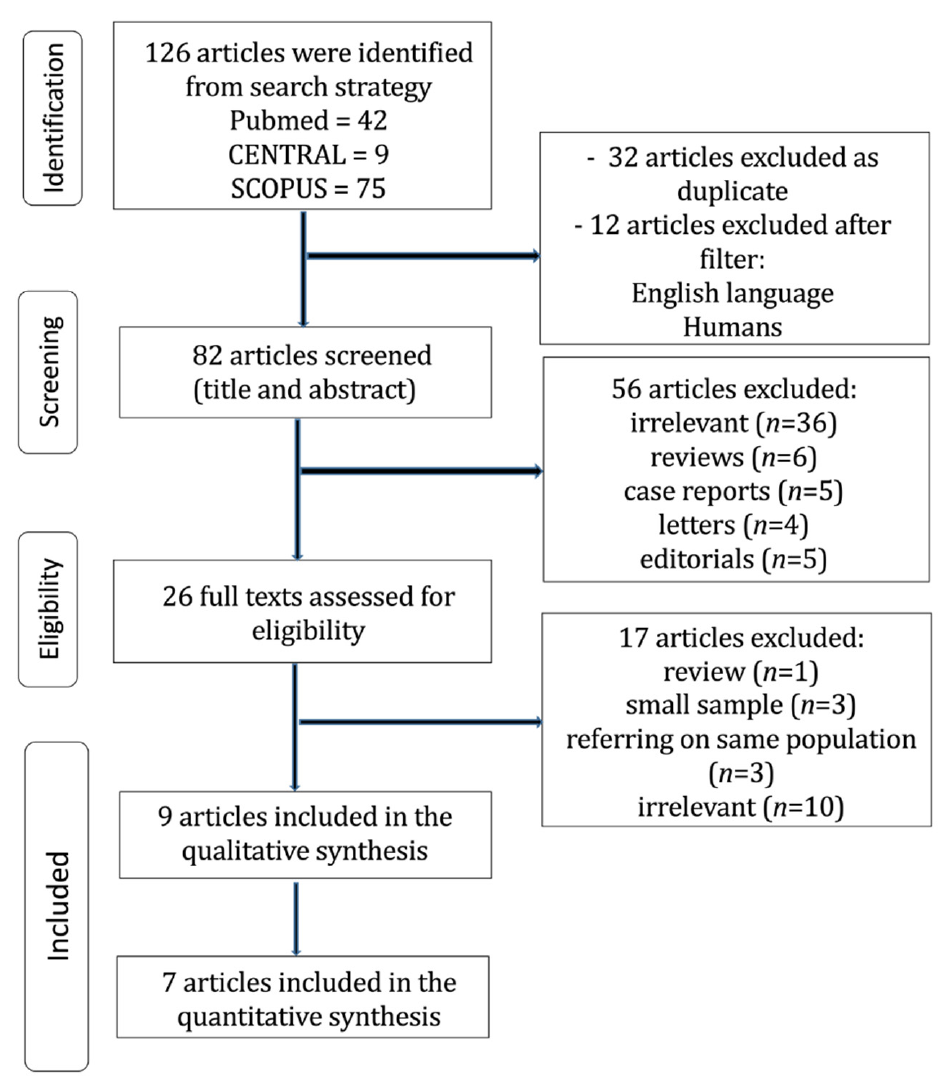
Figure 2. Trial flow of the current meta-analysis.